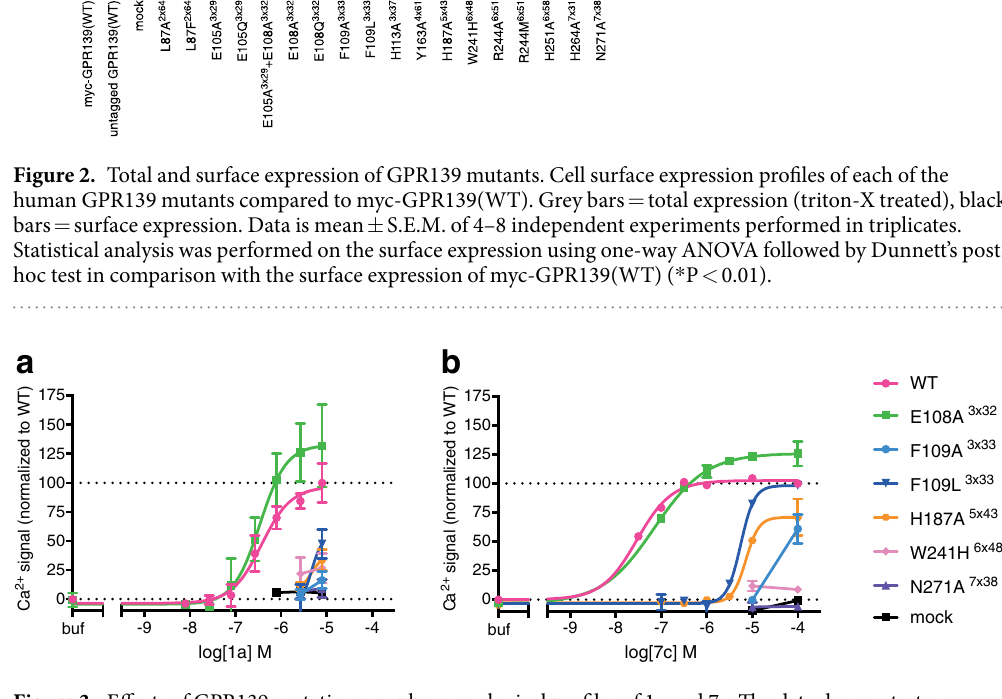
In silico mutation effects on calculated binding affinities. The initial GPR139- 1a structural model described above was optimized to take into account the mutagenesis data (see methods). This was done by means of iterative MD for scoring, i.e. residues F109A 3 × 33 , H187A 5 × 43 and N271A 7 × 38 . Mutation W241H 6 × 48 also showed drastic effects on ligand potency, but the dynamic role of this residue (activation switch in class A GPCRs 31 ) precluded us from